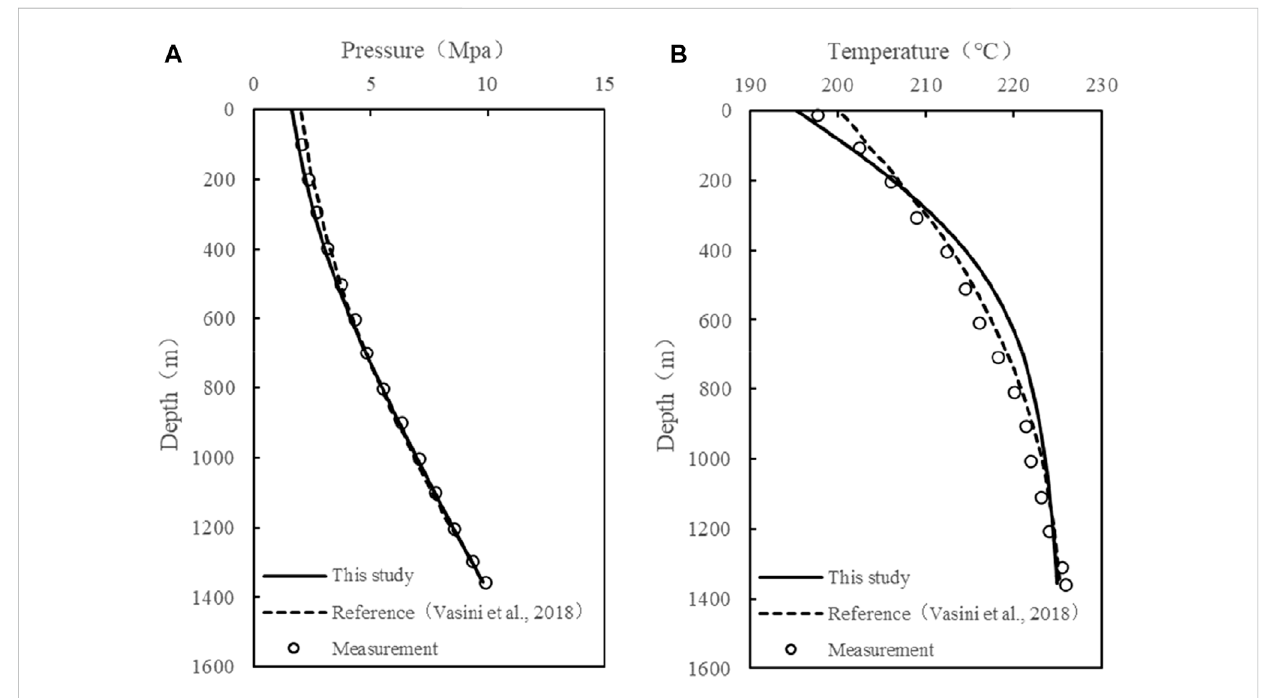
FIGURE 6 Comparison with T2Well-EWASG: (A) pressure and (B) temperature.